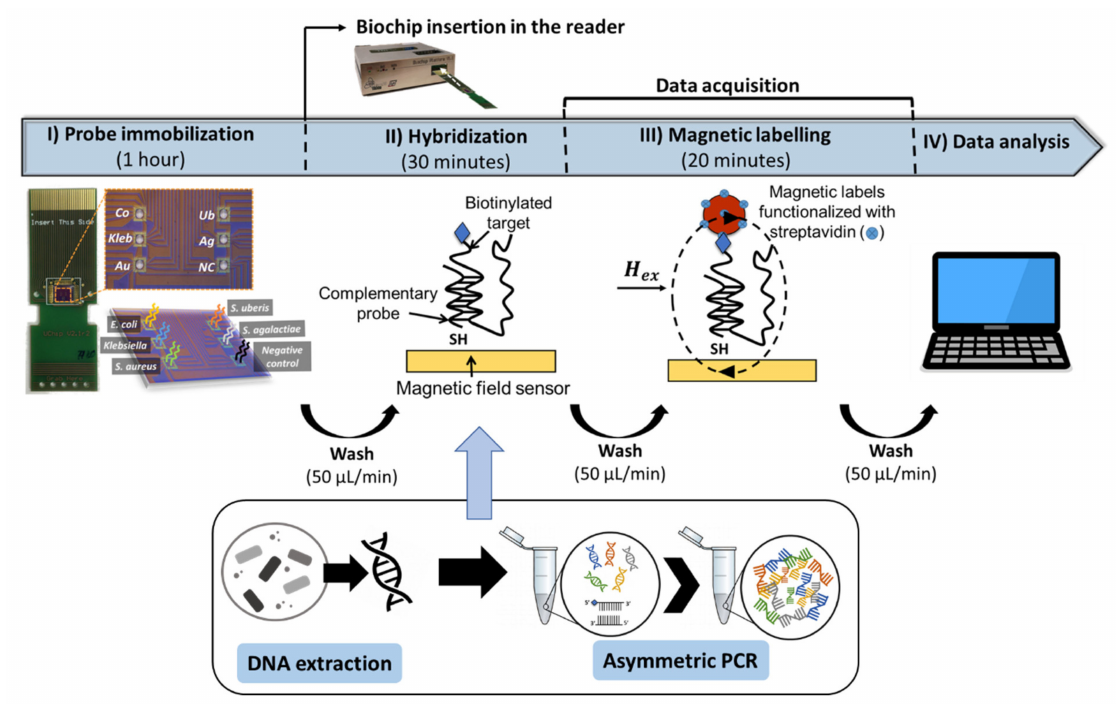
Figure 2. Schematic representation of the main steps involved in a